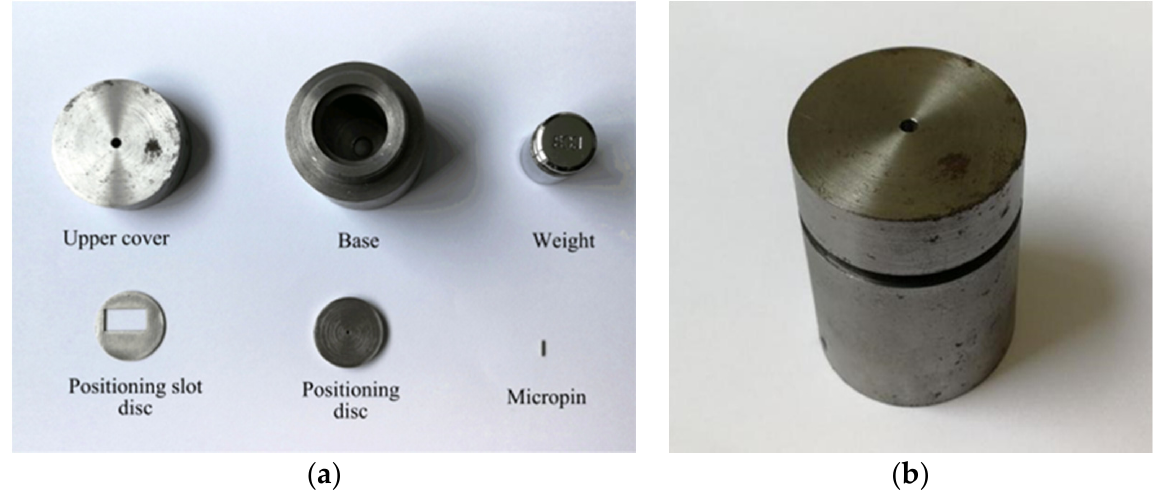
Figure 18. Shear pin test tooling. ( a ) Before; ( b ) After.